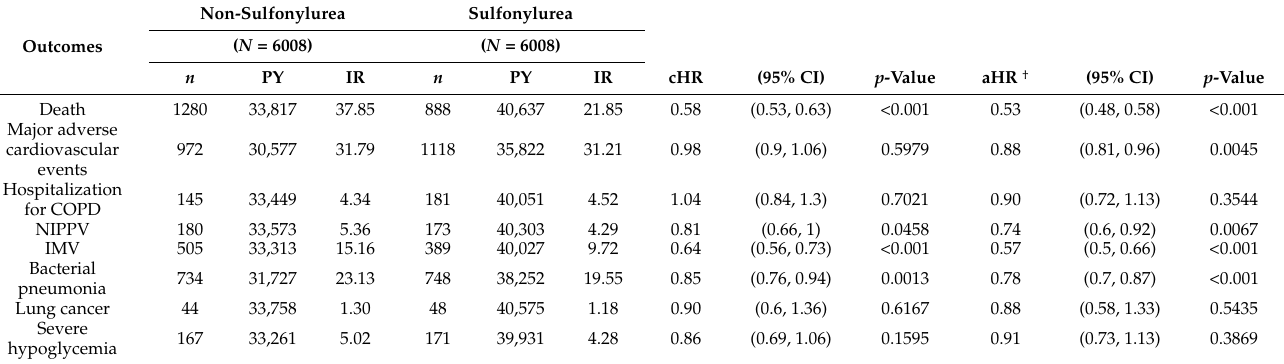
Table 2. Outcomes between sulfonylurea versus non-sulfonylurea in patients with coexisting COPD and T2D.